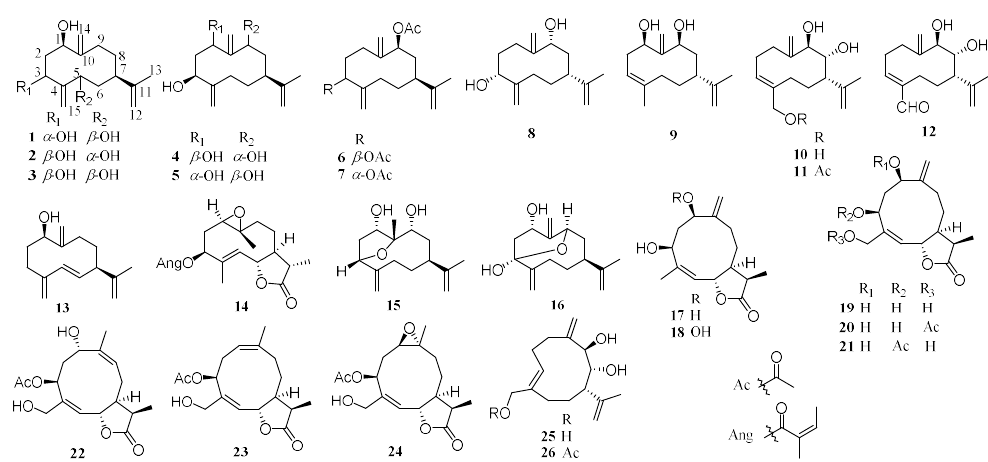
Figure 1. Germacrane-type sesquiterpenoids from Chrysanthemum genus.